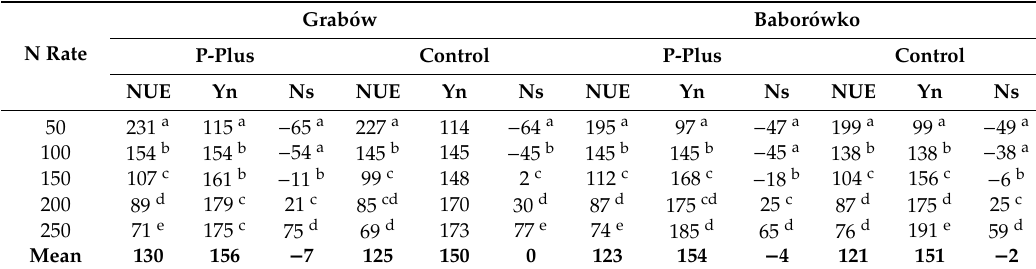
Table 7. N use indices for maize; N fertilizer rate, Yn (uptake), Ns (surplus) (kg · ha − 1 ); NUE (%) for the P fertilizer addition (P-plus) and control (no P addition).